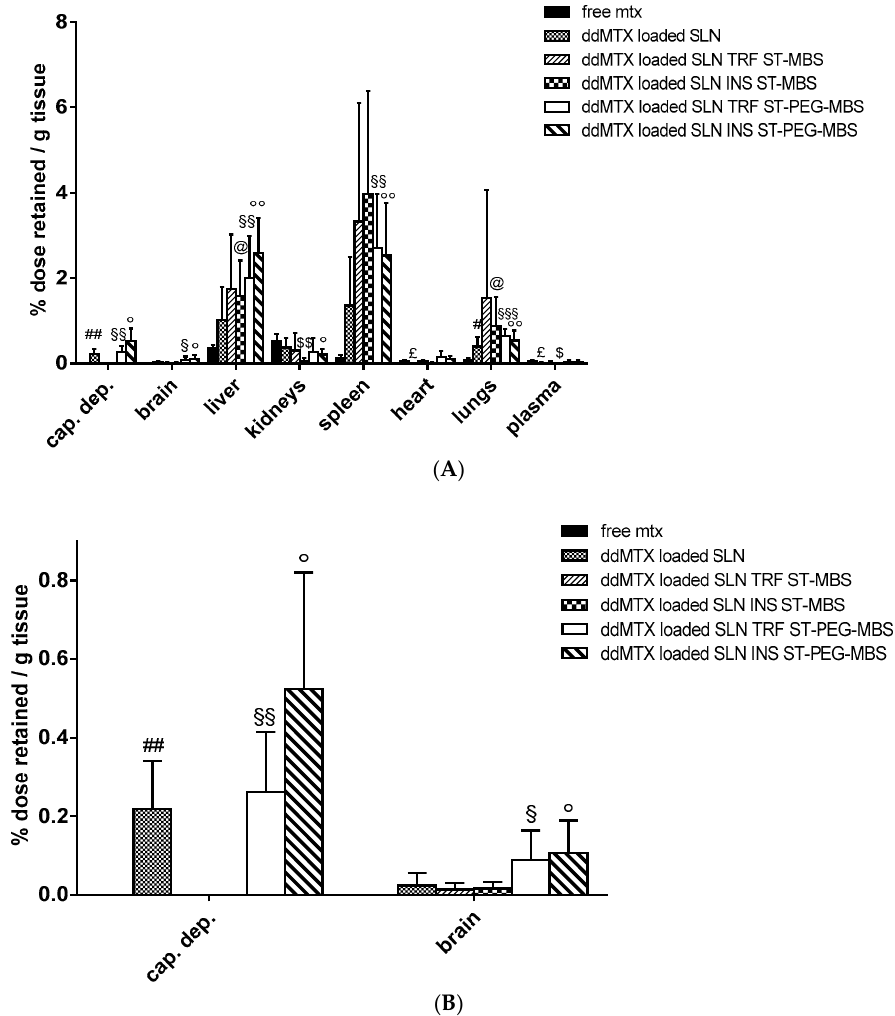
Figure 4. Biodistribution of functionalized ddMTX-loaded SLNs and free MTX (sacrifice 3 h after